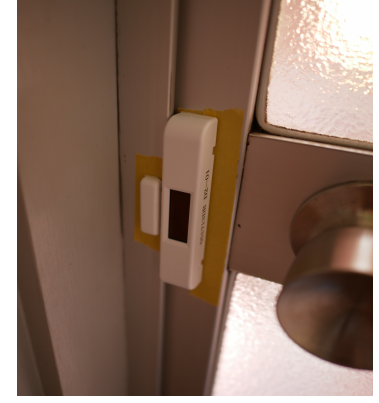
Figure 3. Door sensor.